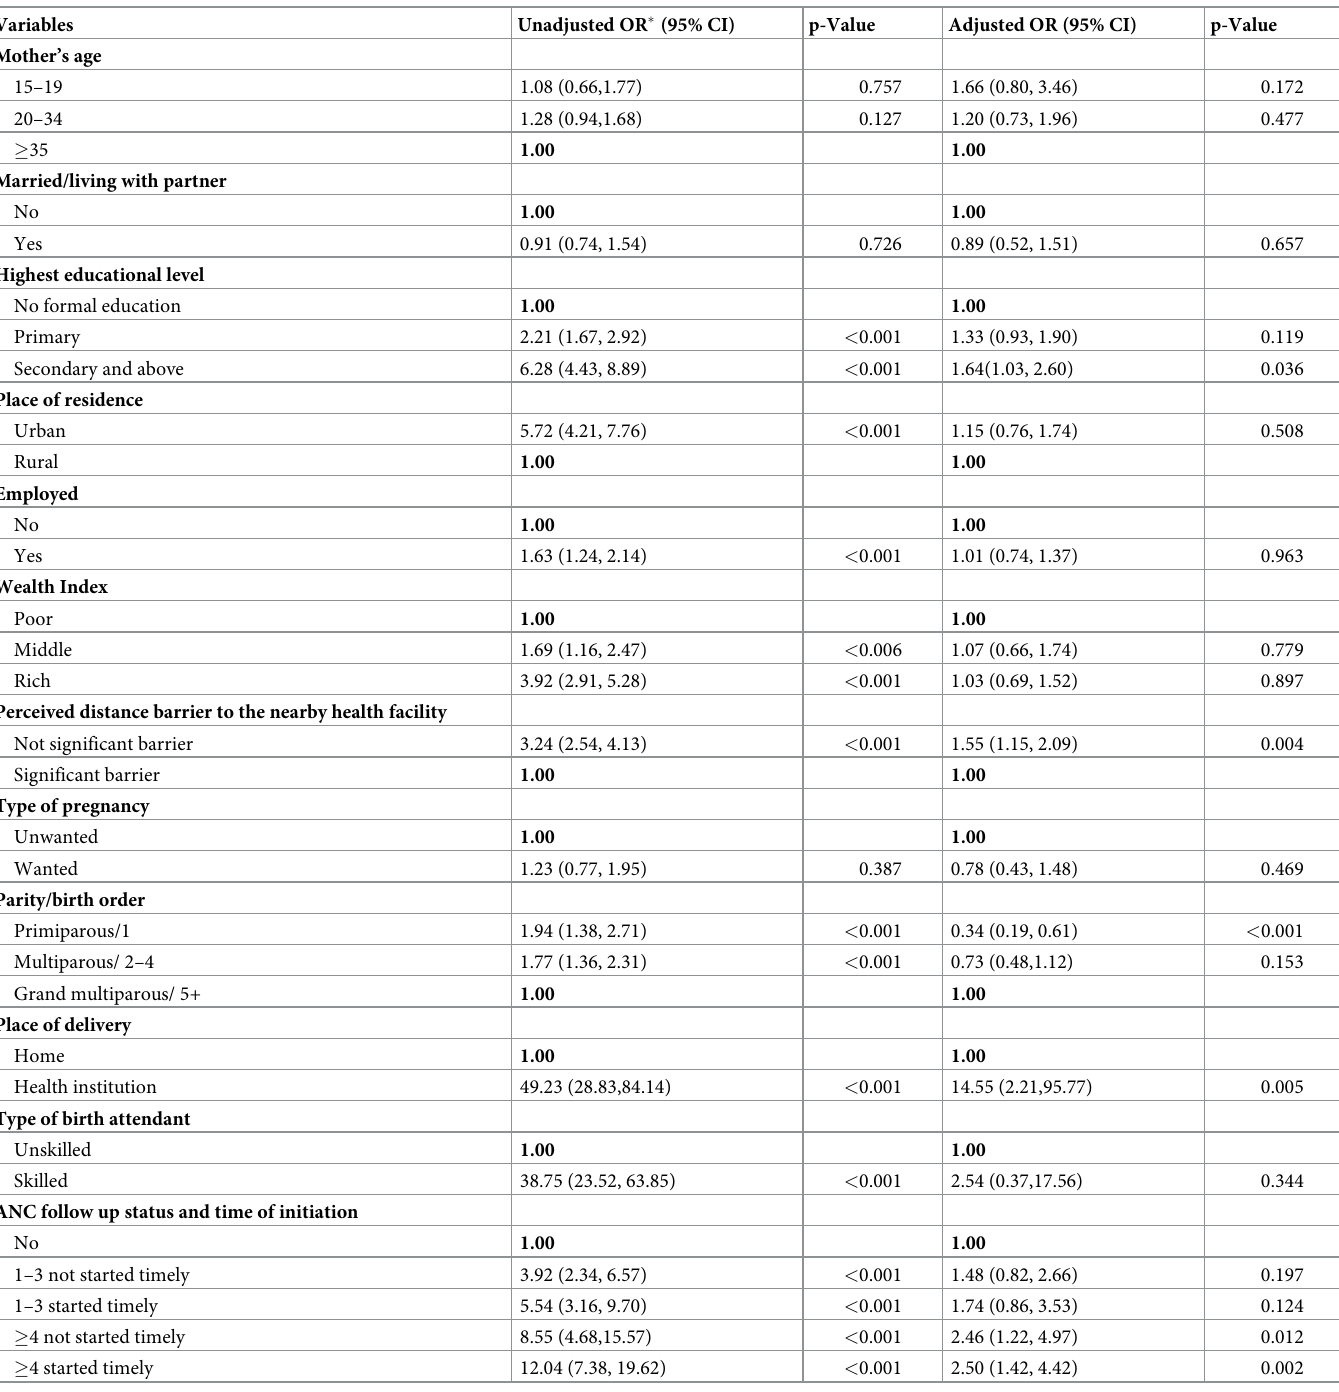
Table 3. Association between ANC follow up pattern and timely postnatal checkup (N =